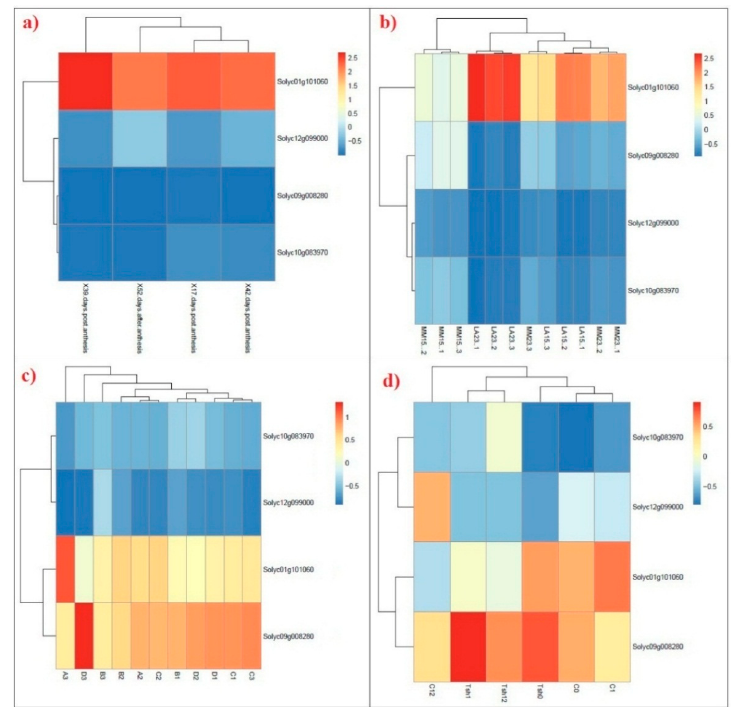
Figure 7. Heat map of the expression profiles of tomato SAMS genes under different stresses. ( a ) transcription profile of SAMS genes at developmental stages of tomato fruit obtained from RNA-seq dataset with accession ID: E-MTAB-4818 (X17, 39, 42, and 59 denote 17, 39, 42, and 52 days post-anthesis, respectively); ( b ) transcription profile of SAMS genes in tomato roots under low temperature stress obtained from RNA-seq dataset with accession ID: E-MTAB-4855 (LA23: S. habrochaites LA1777 at 23 °C; LA15: S. habrochaites LA1777 at 15 °C; MM23: S. lycopersicum Moneymaker at 23 °C; LA15: S. lycopersicum Moneymaker at 15 °C); ( c ) transcription profile of SAMS genes in tomato shoot under biotic stress [25], (A: control; B: treatment with Pseudomonas syringae pv. Tomato DC3000; C: nightly red light treatment; D: treatment with P. syringae pv. Tomato DC3000+ nightly red light treatment); ( d ) transcription profile of SAMS genes in tomato shoot under cold stress [26], (C0, C1 and C12: S. lycopersicum at 0, 1, and 12 h at 4 °C, respectively; Tsh0, Tsh1, and Tsh12: S. habrochaites at 0, 1, and 12 h at 4 °C, respectively).